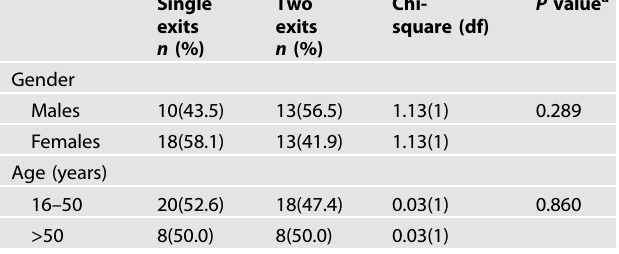
Table 6. Overall association of the different demographic factors with the number of MB-2 exit(s) in maxillary second molars ( n =